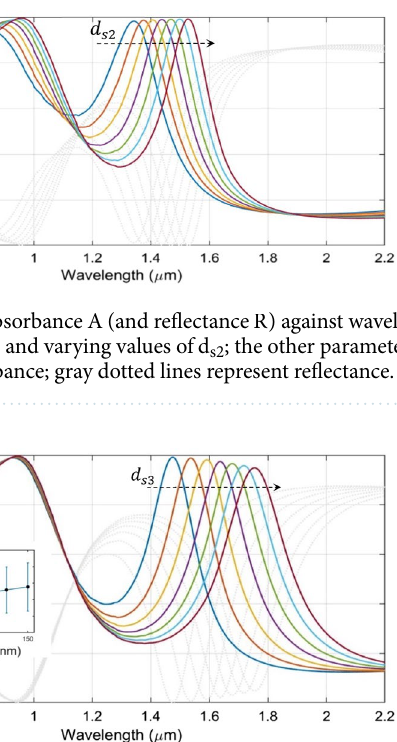
Figure 6. Plots of absorbance A (and reflectance R ) against wavelength under fixed values of d GST1 (= 130 nm), d GST2 (= 70 nm), and d s2 (= 120 nm), and varying values of d s3 ; the other parameters are used as before. Coloured lines correspond to absorbance; gray dotted lines represent reflectance. The dashed arrow represents increase in d s3 . The inset diagram compares the different absorption spans using different values of d s3